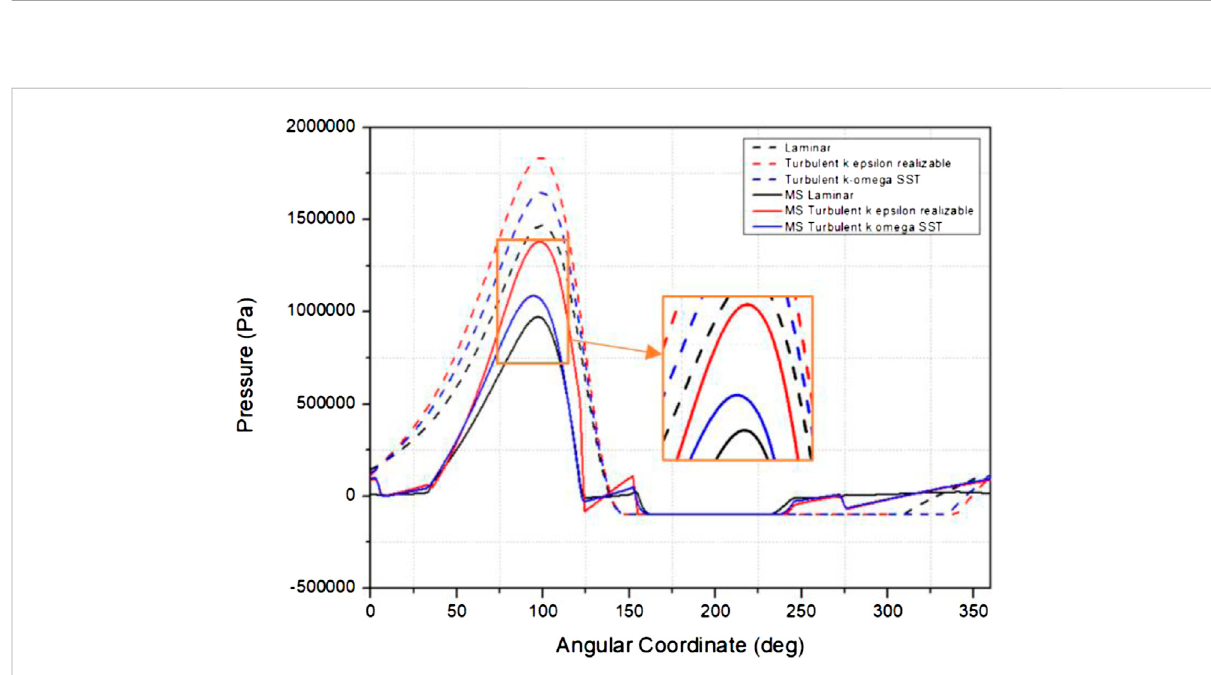
FIGURE 8 Plot of pressure at the midplane smooth journal bearing and multistep journal bearing, ε = 0.7 dan ω = 3,000